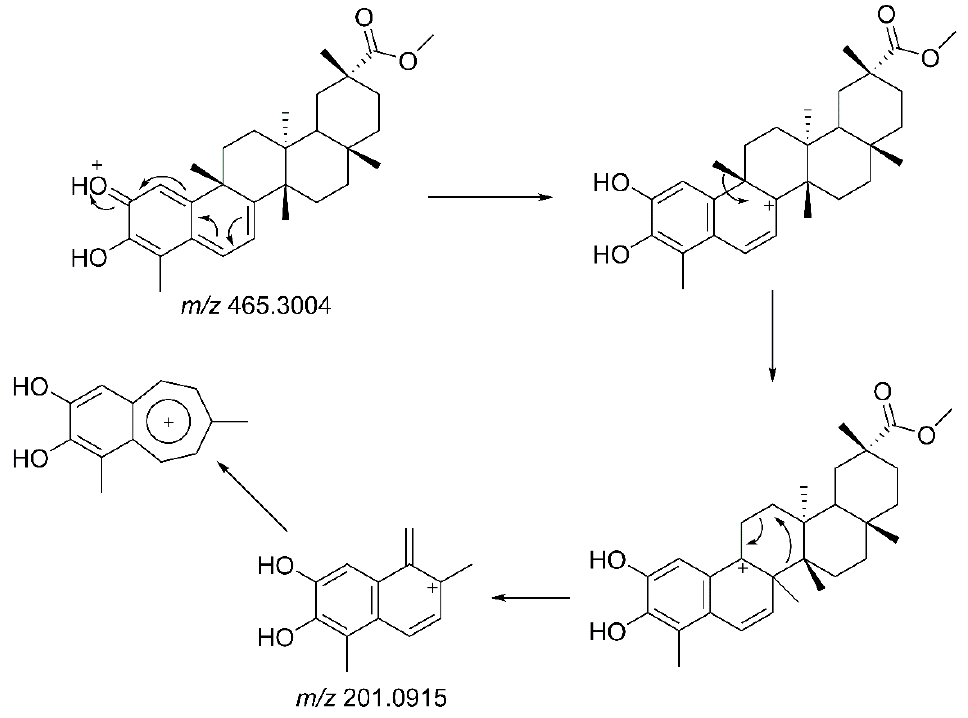
Figure 3. Proposed fragmentation for pristimerin ( 2 ).